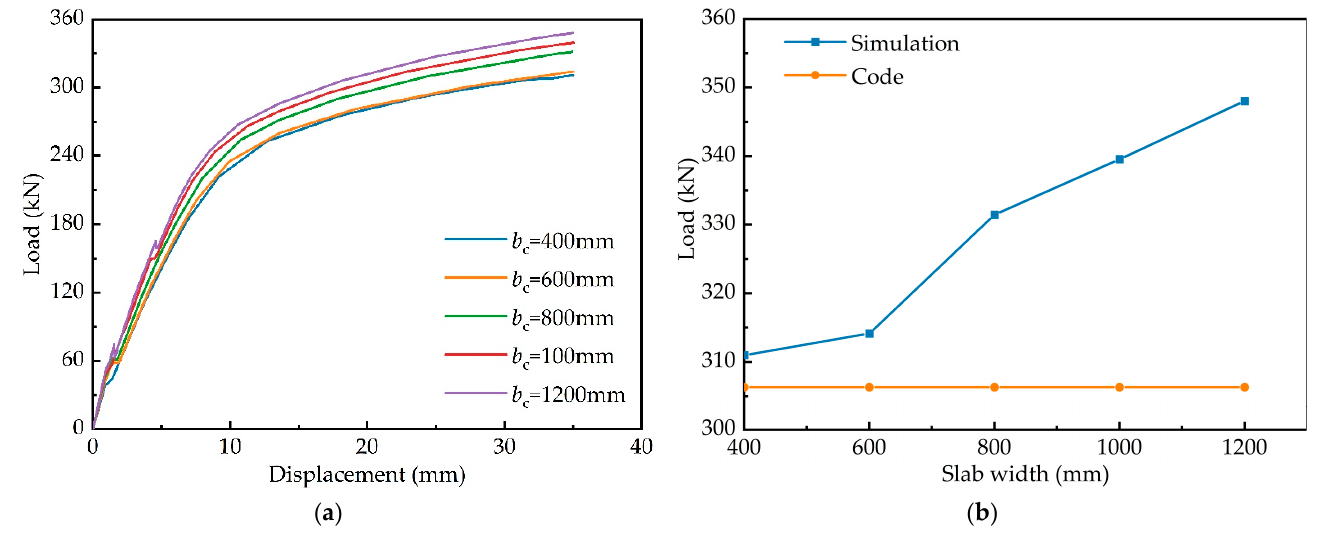
Figure 16. Effects of slab width: ( a ) load–deflection curves; ( b ) comparison of flexural bearing ca- pacity.